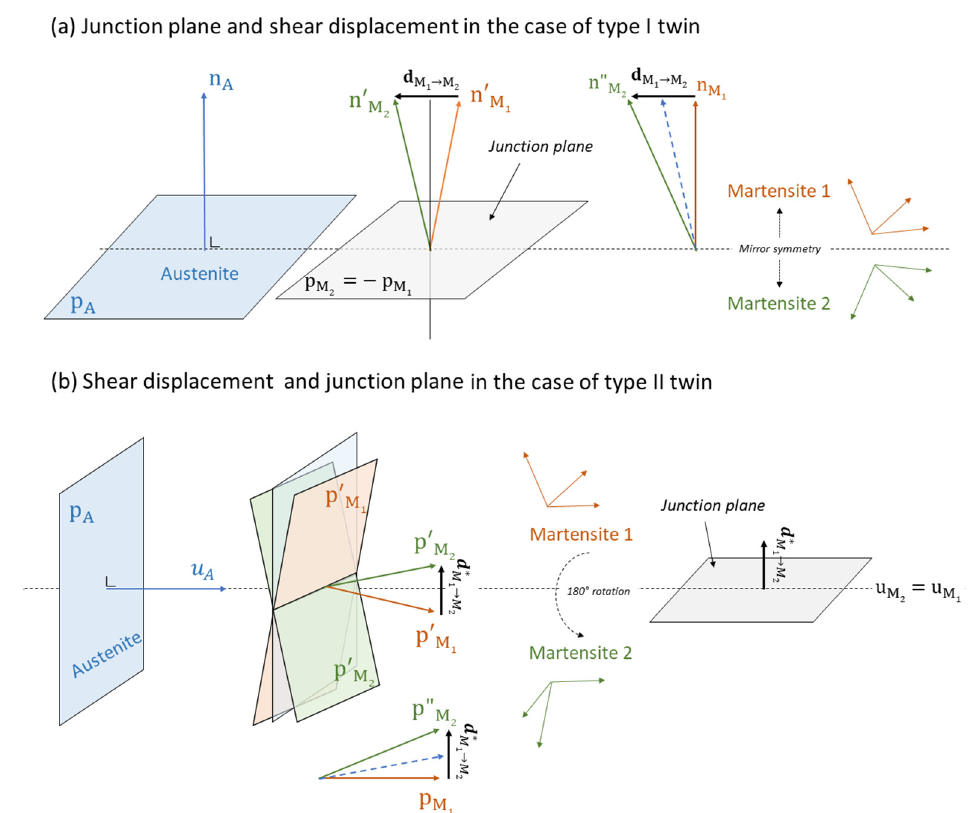
Figure 2. Junction plane between variants M 1 and M 2 deduced from the austenite symmetry op- eration that links them. ( a ) Reflection on the austenite plane 𝐩 (cid:2885) , and ( b ) 180° rotation around the austenite axis 𝐮 (cid:2885) .